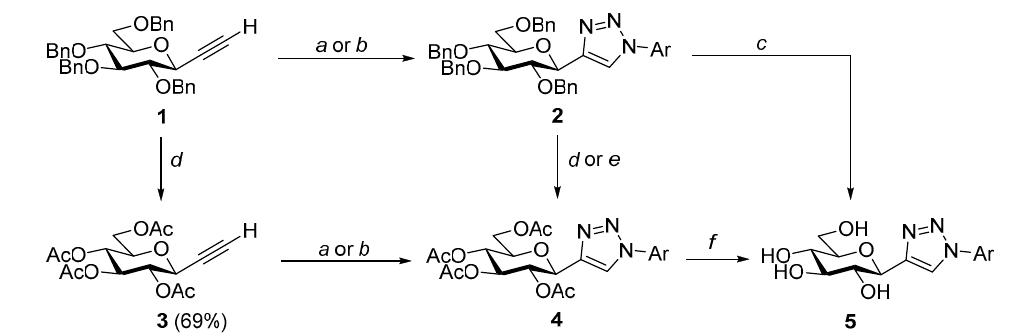
Table 2. Synthesis of 1-aryl-4-( β - D -glucopyranosyl)-1,2,3-triazoles.